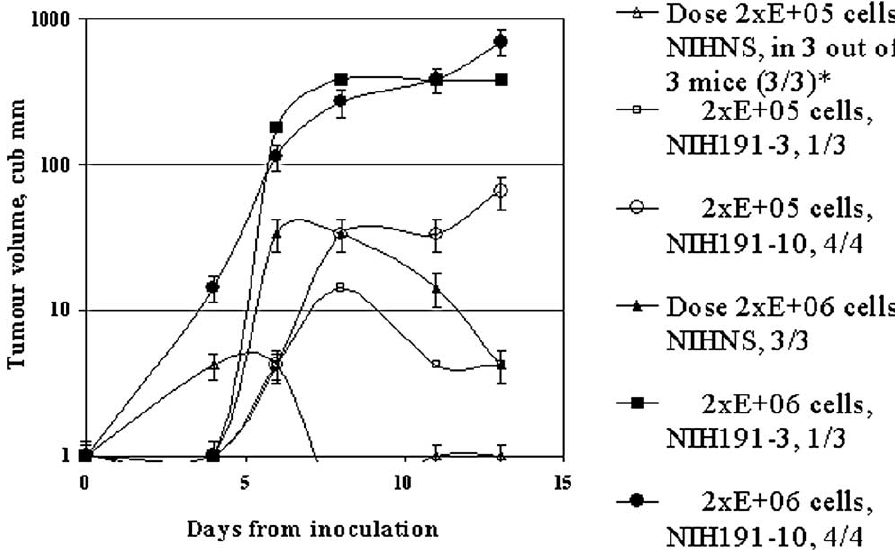
Fig. 5. Tumorigenicity of NIH 3T3-derived stable cell lines expressing HCV core (NIH191-3, NIH191-10), and a control cell line with a low-level expression of HCV NS3 protein (NIHNS), after inoculation into C.B-17/SCID mice. ∗ Number of mice with palpable solid or soft tumors per total number of